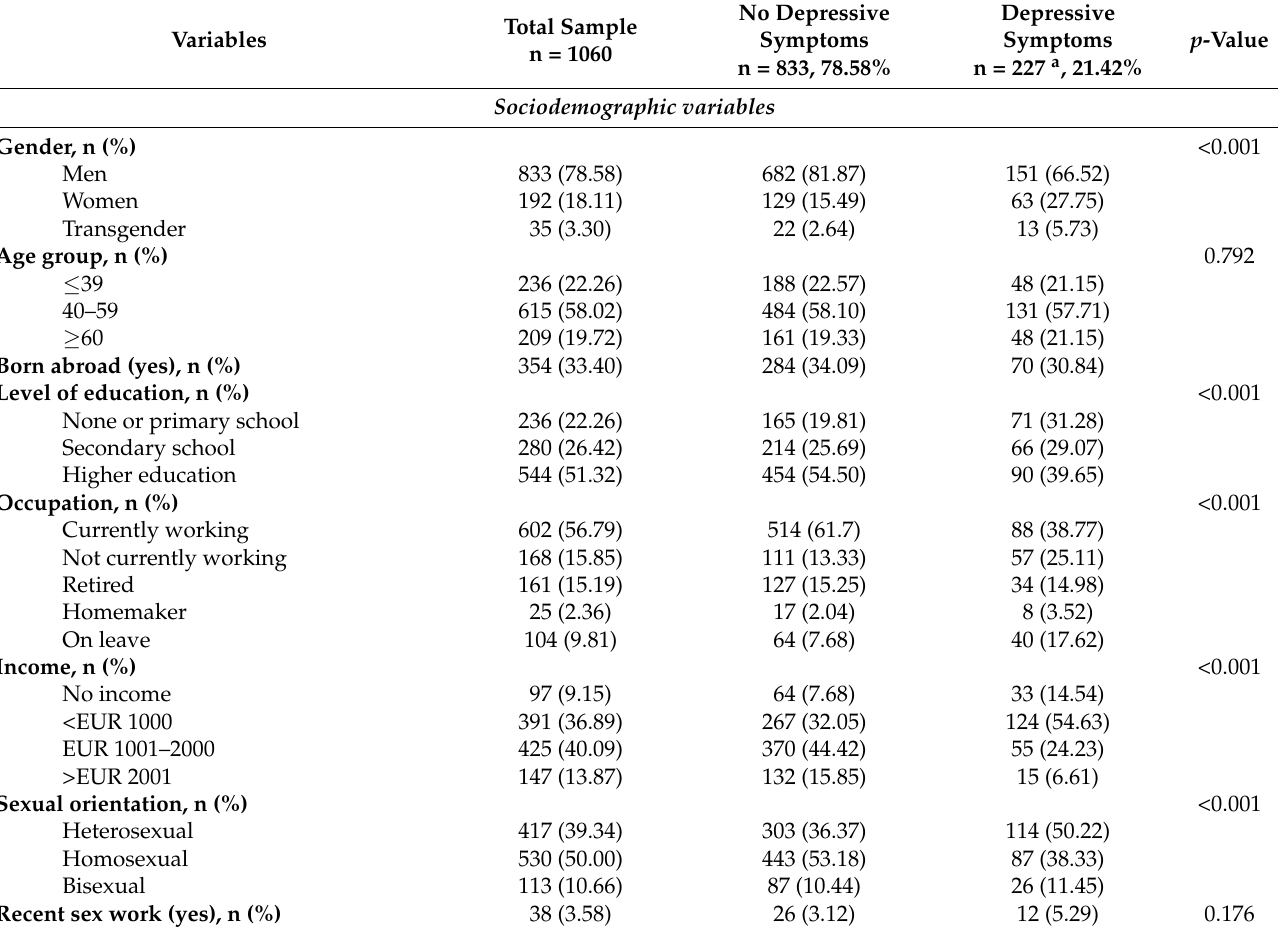
Table 1. Characteristics of the total sample by prevalence of depressive